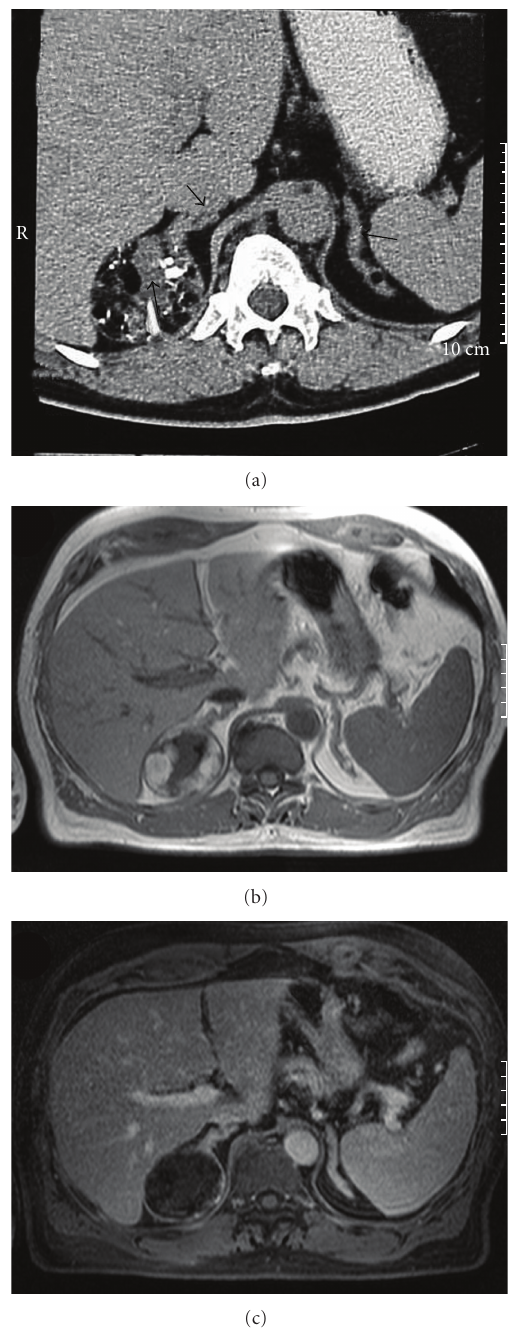
Figure 1: Computed tomography of the adrenals in Patient 1. (a) Arrows show a 5.7 centimetre large, expansive process in the right adrenal with a heterogeneous stroma, fat, calcifications, and in addition, pronounced bilateral adrenal hyperplasia. Magnetic resonance images of the adrenal tumor , T1 Weighted Imaging, with hyperintense fat (b) showing signal loss in fat suppressed image (c).